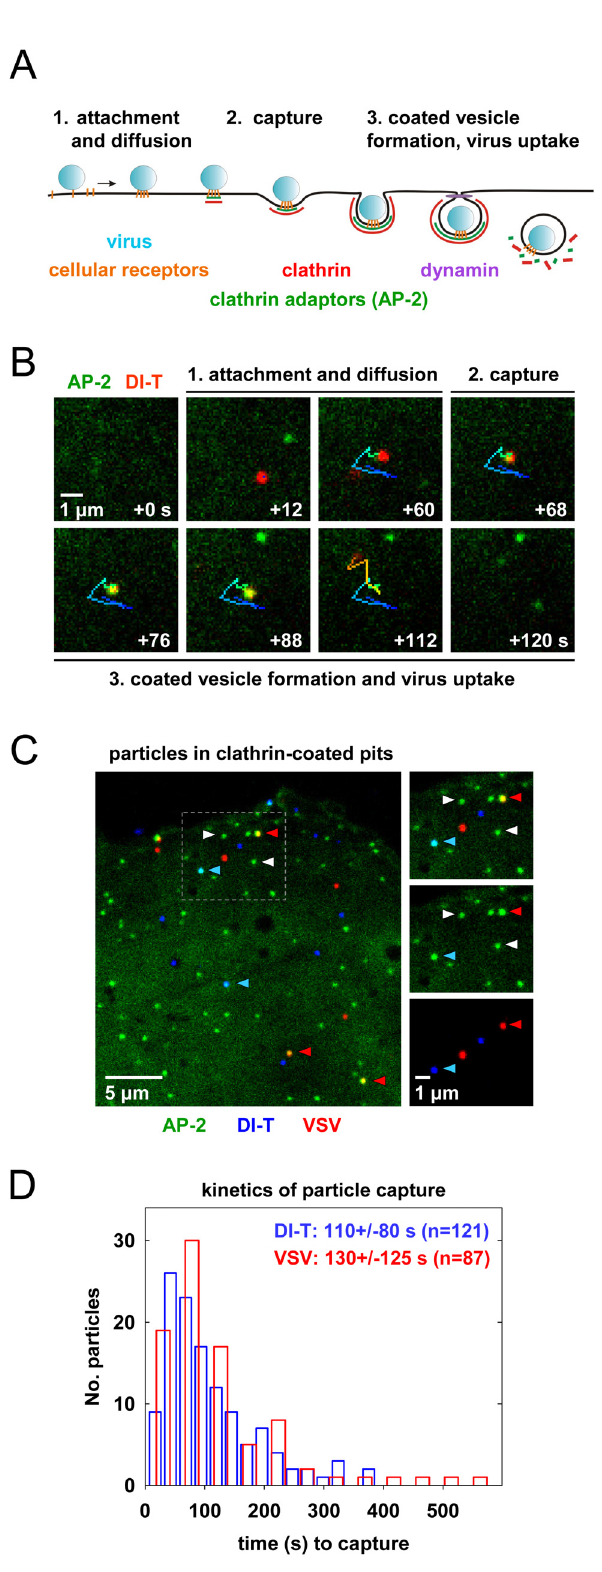
Figure 2. Clathrin structures capture VSV and DI-T particles with similar kinetics. (A) Schematic of clathrin-dependent virus internalization. 1. A particle (blue) attaches to receptor moieties (orange) on the cell surface (black horizontal line), and the virus- receptor complex diffuses in the plane of the membrane. 2. The virus particle is captured by the clathrin endocytic machinery (AP-2,